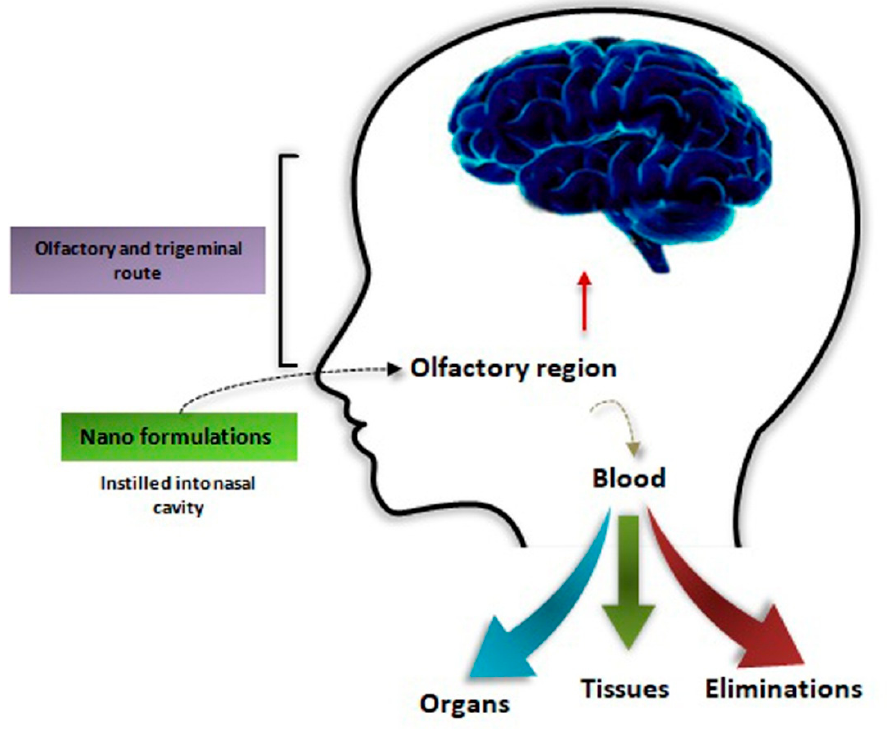
Figure 4. Brain targeting pathways in intranasal administration.